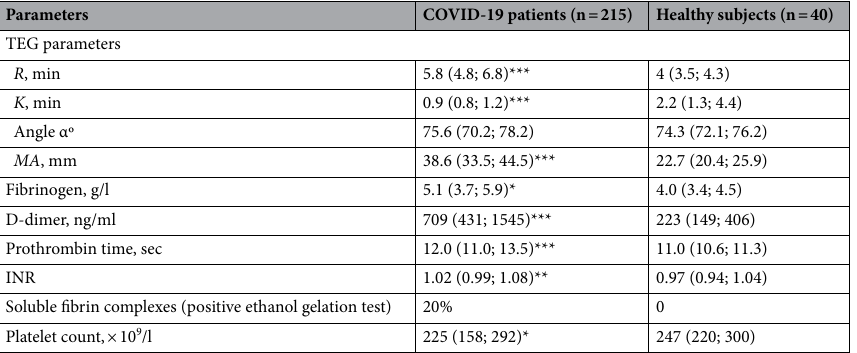
Table 2. Hemostatic parameters in COVID-19 patients and healthy subjects. Results are presented as median and interquartile range (25th and 75th percentiles). *p < 0.01, **p < 0.001, ***p < 0.0001; Mann–Whitney U-test.